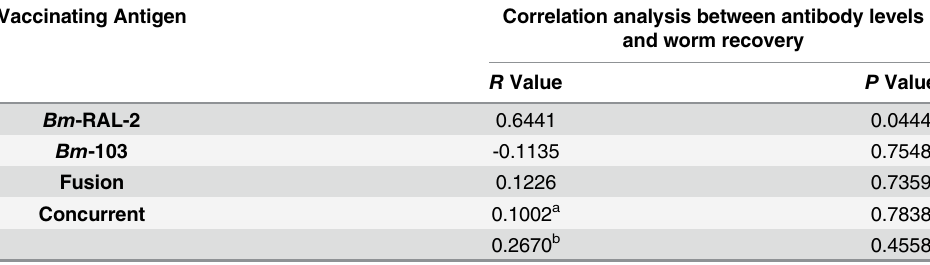
Table 4. Correlation analysis between antibody levels and worm recovery. Vaccinating